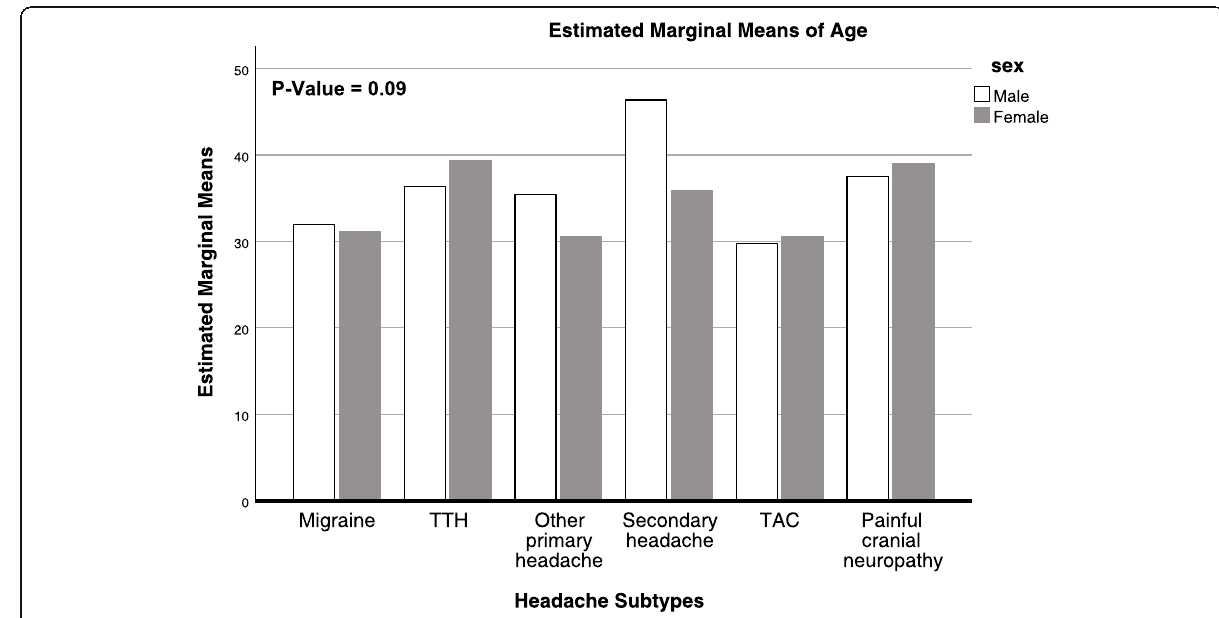
Fig. 2 Mean age for males and females in different headache